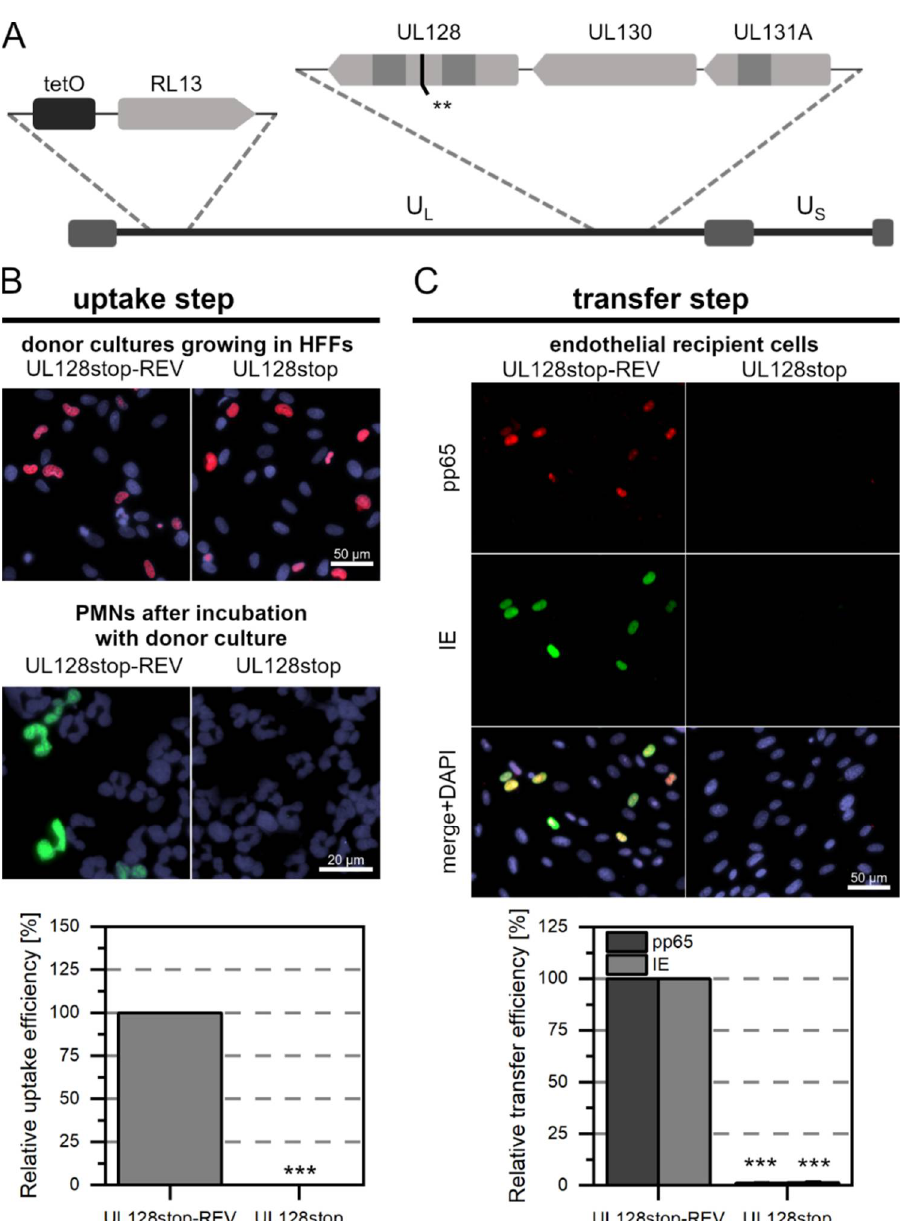
Figure 2. The pentameric HCMV complex is essential for PMN-mediated transmission to endothelial cells as it is critical for virus uptake into PMNs. ( A ) Genomic overview of the generated Merlin mutant representing the unique long (U L ) and short (U S ) sections: the mutant carries the tet operator upstream of RL13. In comparison to the wild-type, two consecutive stop codons (**) were introduced into the ORF of the UL128 gene of the UL128-131A locus, as indicated. ( B ) Characterization of the uptake step to PMNs. PMNs were isolated from EDTA blood of HCMV-seronegative donors and incubated for 3 h at 37 °C with Merlin-RL13tetO-UL128stop or its revertant Merlin-RL13tetO-UL128stop-REV. PMNs were recollected, and a fraction was used for the preparation of cytospots. Donor cultures were fixed and stained via indirect immunofluorescence for viral IE Ag (pink